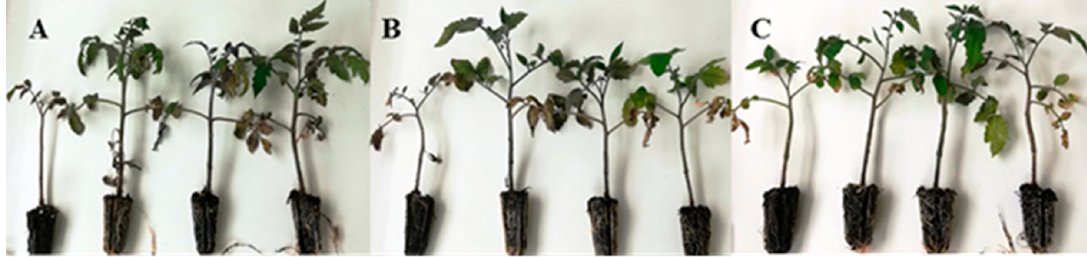
Figure 1. Seedlings of ‘Pearson’ ( A ), ‘H3402 ′ ( B ), and ‘Everton’ ( C ) at regrowth. In each square, from left to right: CTRL, G, B and G + B. CTRL = seedlings without microorganism treatment, G = seedlings inoculated with Funneliformis mosseae , B = seedlings with Paraburkholderia graminis inoculated, G + B = seedlings inoculated with Funneliformis mosseae + Paraburkholderia graminis.